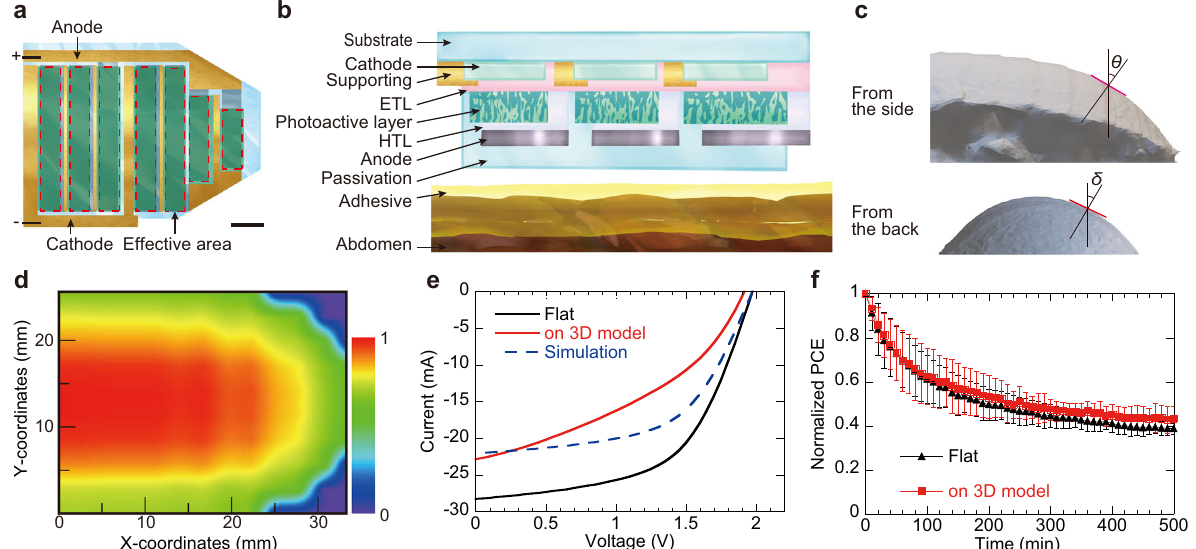
Fig. 3 Large-area organic solar cell module for cyborg insects. a Top view design of organic solar cell module. The dashed red lines indicate the effective area of the module. Scale bar, 5 mm. b Structure of the module. c Side and back views of the abdomen showing changes in the angle of light incident in each region. d Estimated distribution of light intensity changes in the abdomen. e Current – voltage ( I – V ) curves of the solar cell module measured under AM 1.5 G with 100 mW cm – 2 . The black and red solid lines represent the measured performance on the fl at stage and 3D printed curved surface, respectively. The dashed blue line represents the simulated curve from the distribution of the light intensity change. f Normalised PCE change with MPP tracking test time. Black triangles and red squares represent the module measured on the fl at stage and 3D printed curved surface, respectively. Plots represent average values obtained from 5 individual modules, and the error bars represent standard